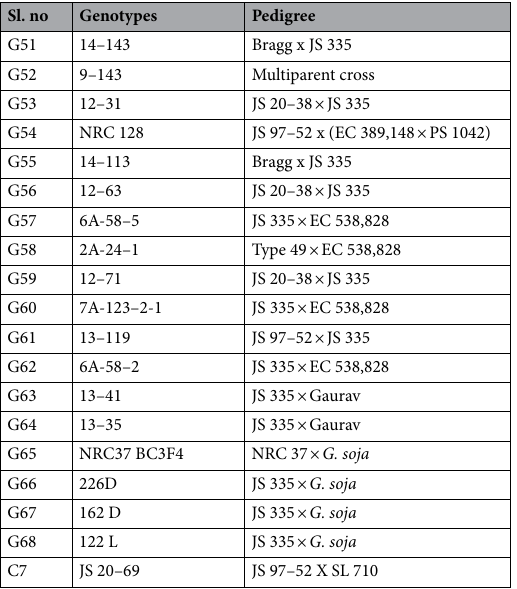
Table 1. List of genotypes along with pedigree used in the evaluation for yield and attributing traits.